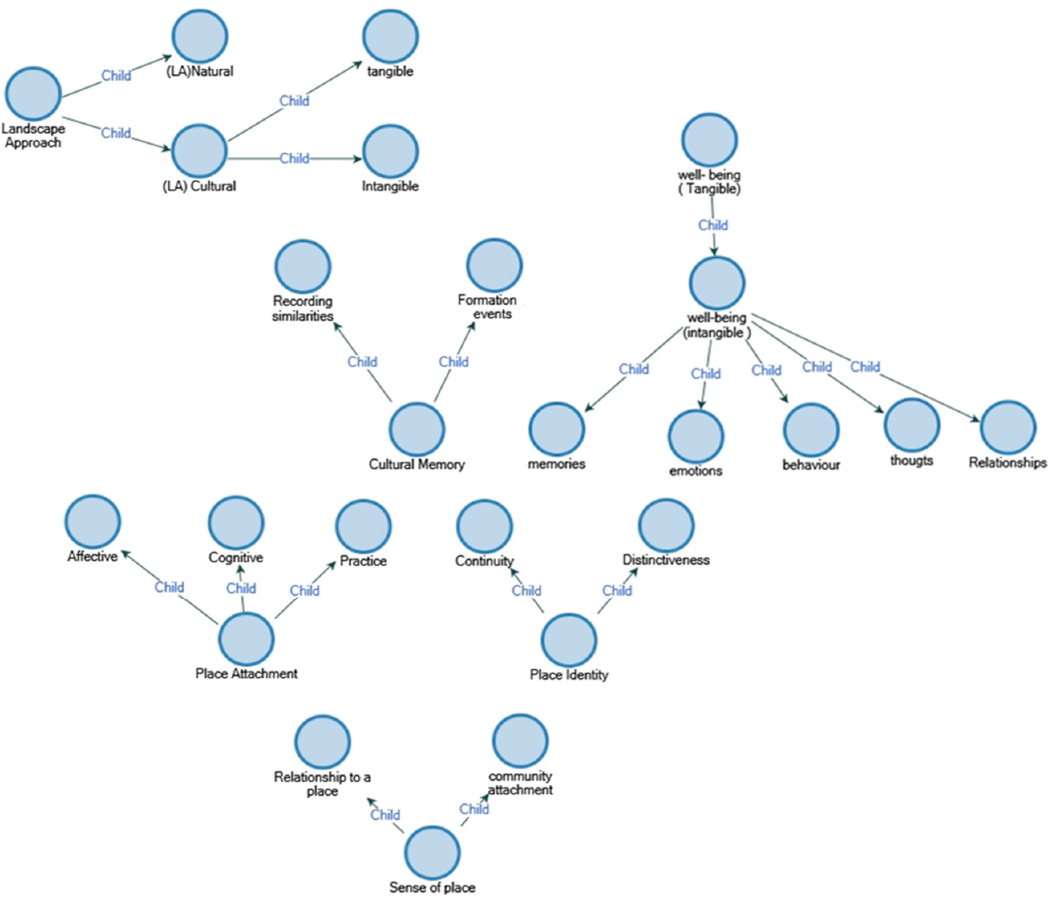
Figure 6. The main research themes used for the coding process (nodes and sub-nodes) as a tree-node diagram extracted from the NVivo12 program. Source: F. Hussein.